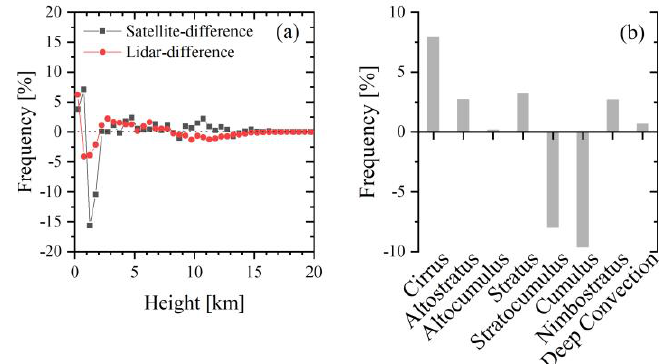
Figure 8. (a) Occurrence frequencies of cloud base height between the two observation sites; (b) Occurrence frequencies of cloud types between the two observation sites. The columns above the horizontal axis indicate an increase in the Hefei site.